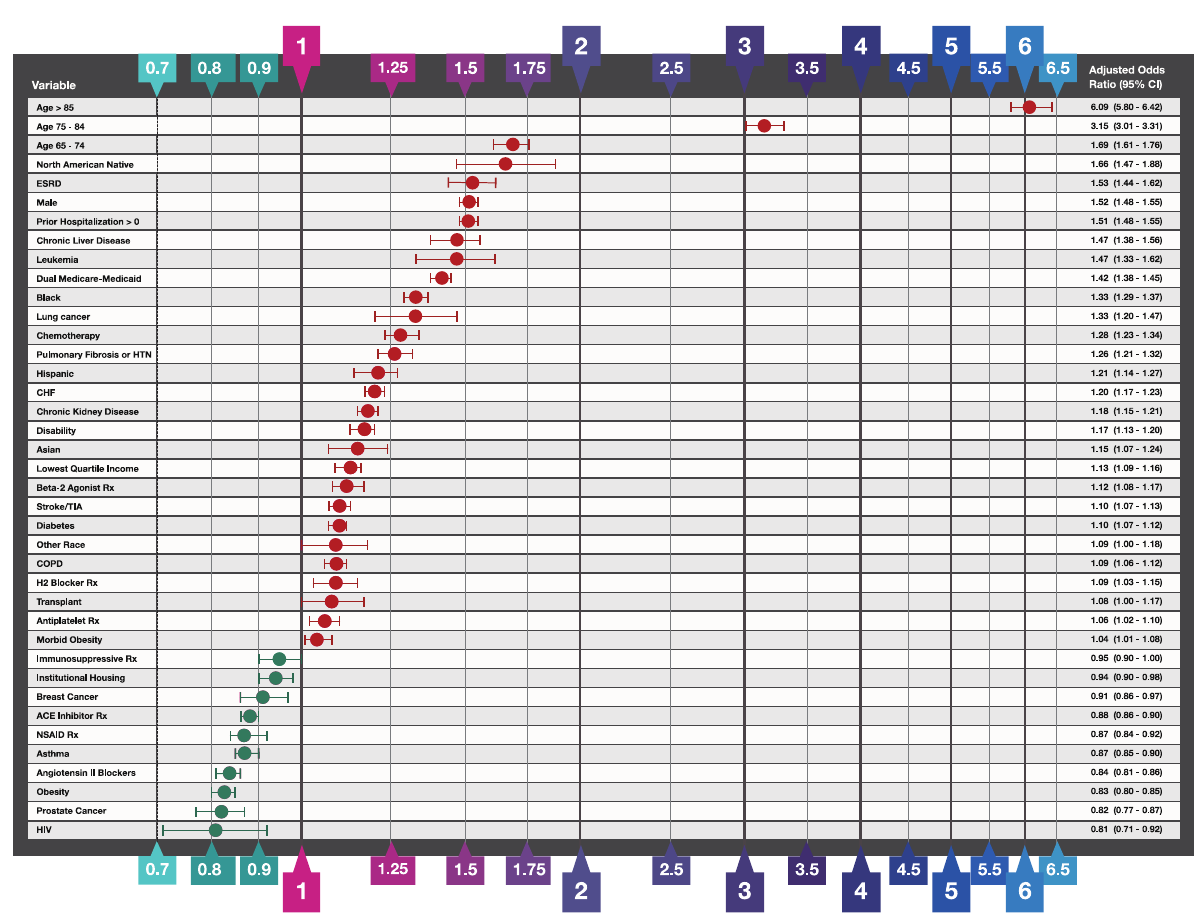
Figure 2. Predictor Variables for COVID-19-Related Death. The independent variable odds ratios were determined by binary logistic regression analysis of confirmed COVID-19 cases that survived versus those that died within 60 days of COVID-19 diagnosis. In addition to, the thirty-nine variables shown in the figure, the following variables were included in the model and survived the variable selection procedure described in Methods but are not shown: prescriptions filled with sufficient quantity to overlap the COVID-19 diagnosis date: Azithromycin (OR 1.18; 95% CI 1.13–1.23), chloroquine and hydroxychloroquine drugs (OR 1.22; 95% CI 1.13–1.23), unknown race (OR 0.88; 95% CI 0.80–0.96). Odds ratios for anemia and prescriptions for anticoagulant drugs and corticosteroids had regression coefficient p values > 0.05 and are not shown. Variables excluded from the model by the variable selection procedure include a history of colorectal cancer and endometrial cancer, or acute MI between July and December 2019, ischemic heart disease, hypertension, residence in zip codes in the top quartile of crowded housing or multiunit housing, and prescriptions for opioid drugs. NSAID Rx signifies treatment with a Non-Steroidal Anti-Inflammatory Drug.